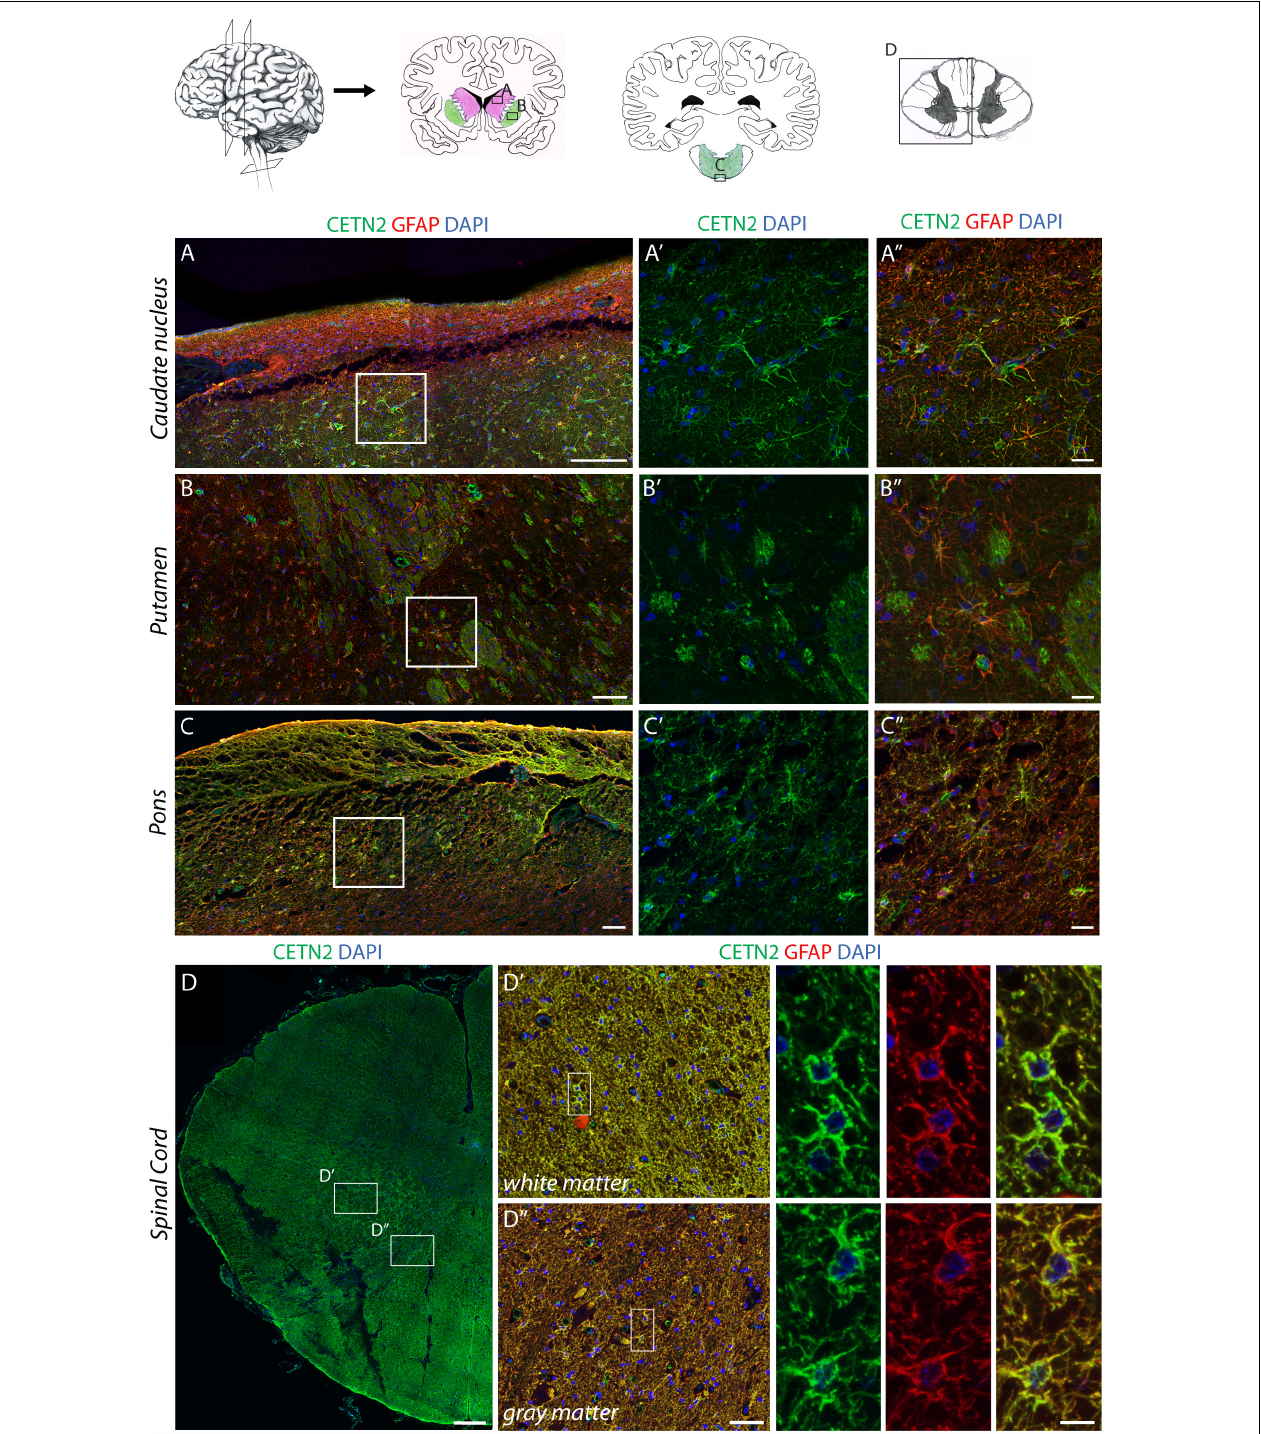
FIGURE 4 | CETN2 expression in human central nervous system astrocytes. (A–A”) CETN2 staining in human subcortical structures. Astrocytes in caudate nucleus, identified by GFAP staining, also exhibit CETN2 immunopositivity. (B–B”) Astrocytes residing in the putamen show CETN2 expression as well as capsula interna fibers. (C–C”) GFAP-positive astrocytes in pons display CETN2 expression mostly detectable at the periphery of the tissue. (D–D”) Transverse section of the human cervical spinal cord with inserts shows high magnification details of gray and white matters, both exhibiting CETN2 expression in astrocytes. Scale bars: (A–C) 100 µ m; (A’,A”,B–B”,C’,C”) 20 µ m, (D) 500 µ m; (D’,D”) 50 µ m; inserts 10 µ m.